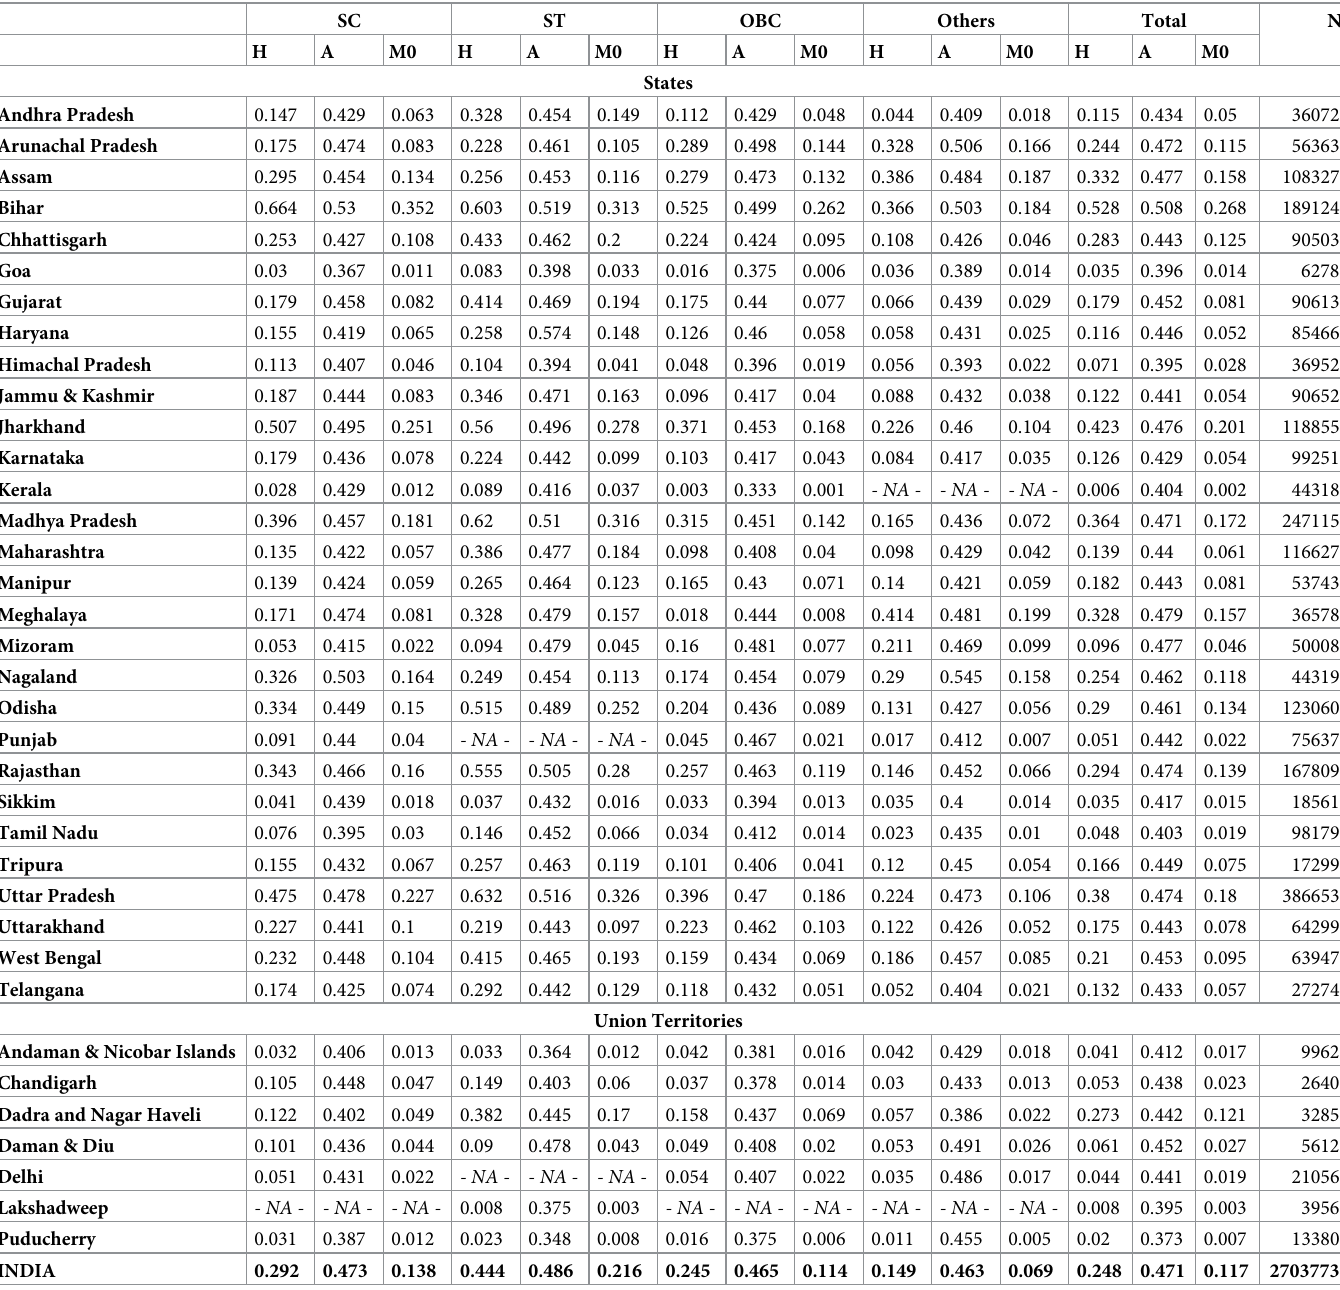
Table 4. Multidimensional poverty across the States and Union Territories by social